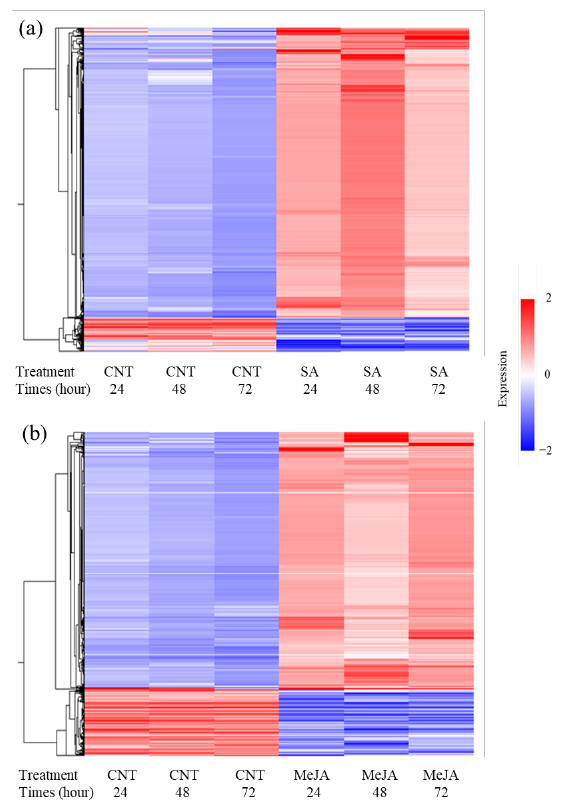
Figure 5. Hierarchical cluster analysis of 1616 salicylic acid-responsive genes and 4914 methyl jasmonate-responsive genes with more than 2-fold expression changes between salicylic acid or methyl jasmonate and control treatments. ( a ) Salicylic acid (SA)/control (CNT) signal intensity ratio; ( b ) Methyl jasmonate (MeJA)/control (CNT) signal intensity ratio. The color scale indicates a signal intensity of each gene. Tree at the left side of the matrix represents gene relationship.